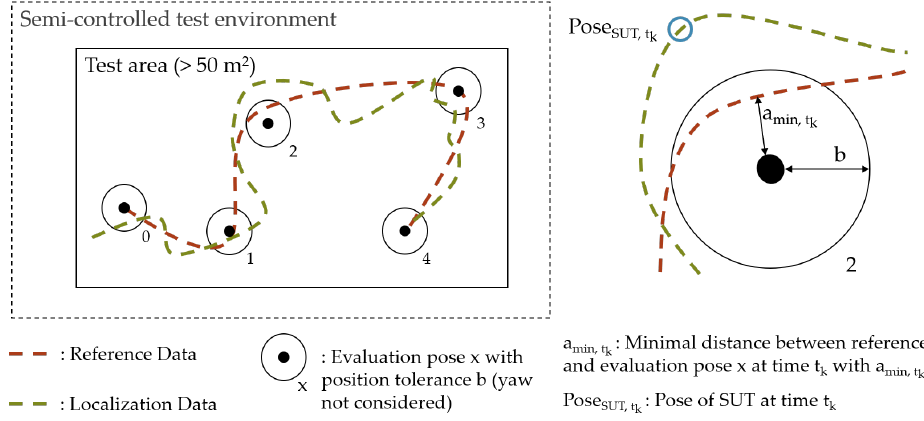
Figure 10. The left side shows a top view of the test area in a semi-controlled test environment, with evaluation poses, interpolated reference data, and aligned localization data. On the right side, a focused view of a test point is shown to illustrate the determination of the Evaluation Data